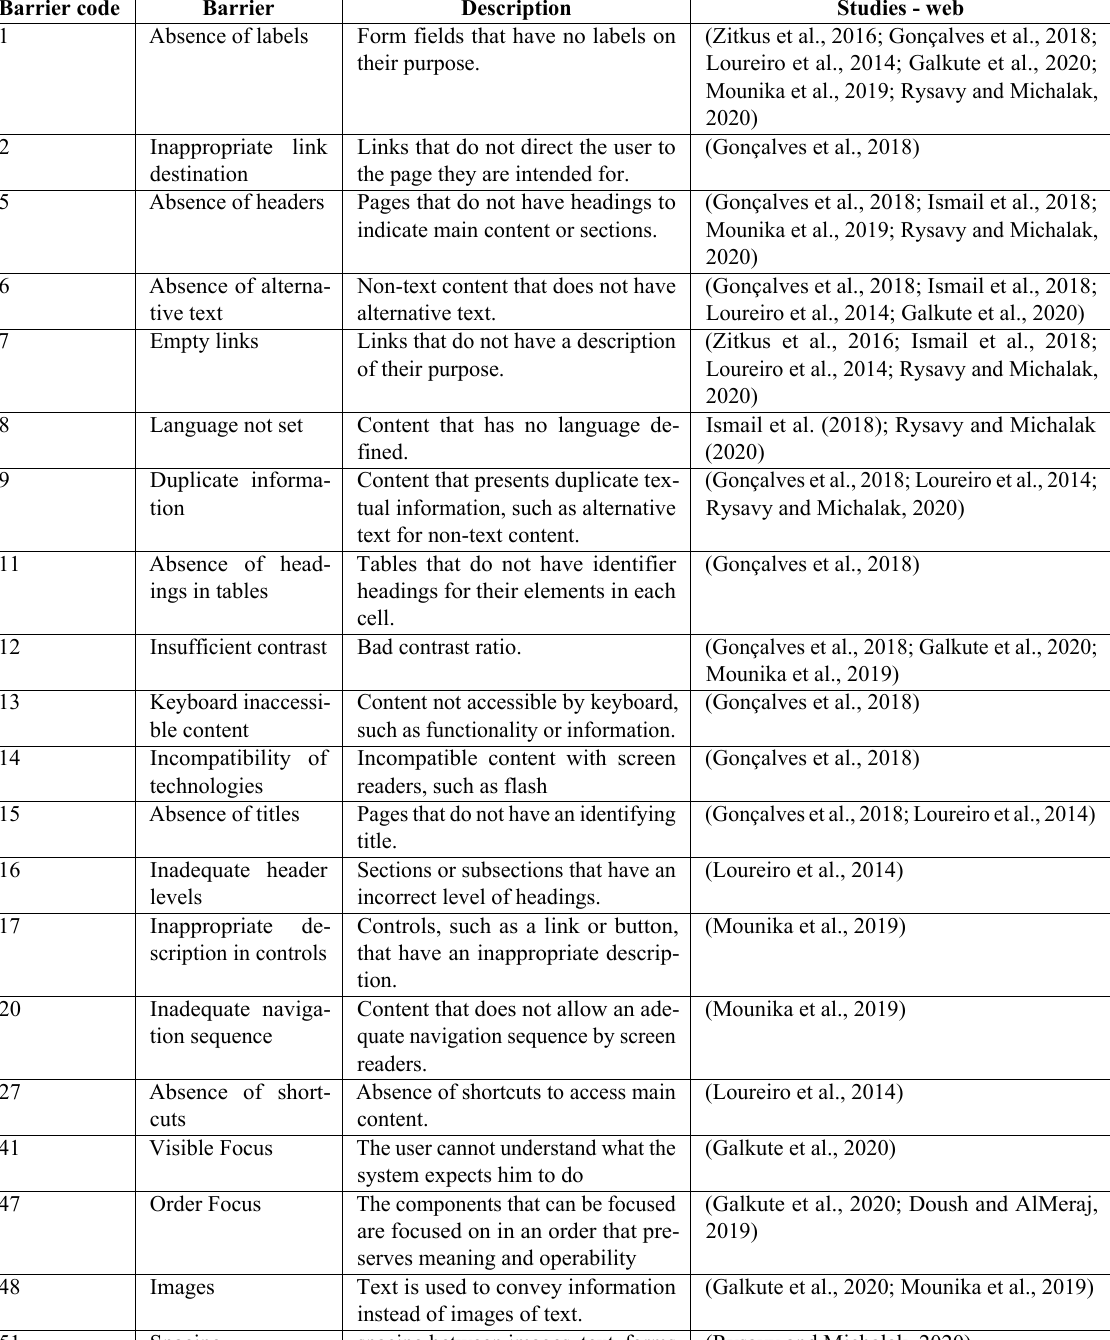
Table 10. Accessibility problems encountered by automated evaluation tools on